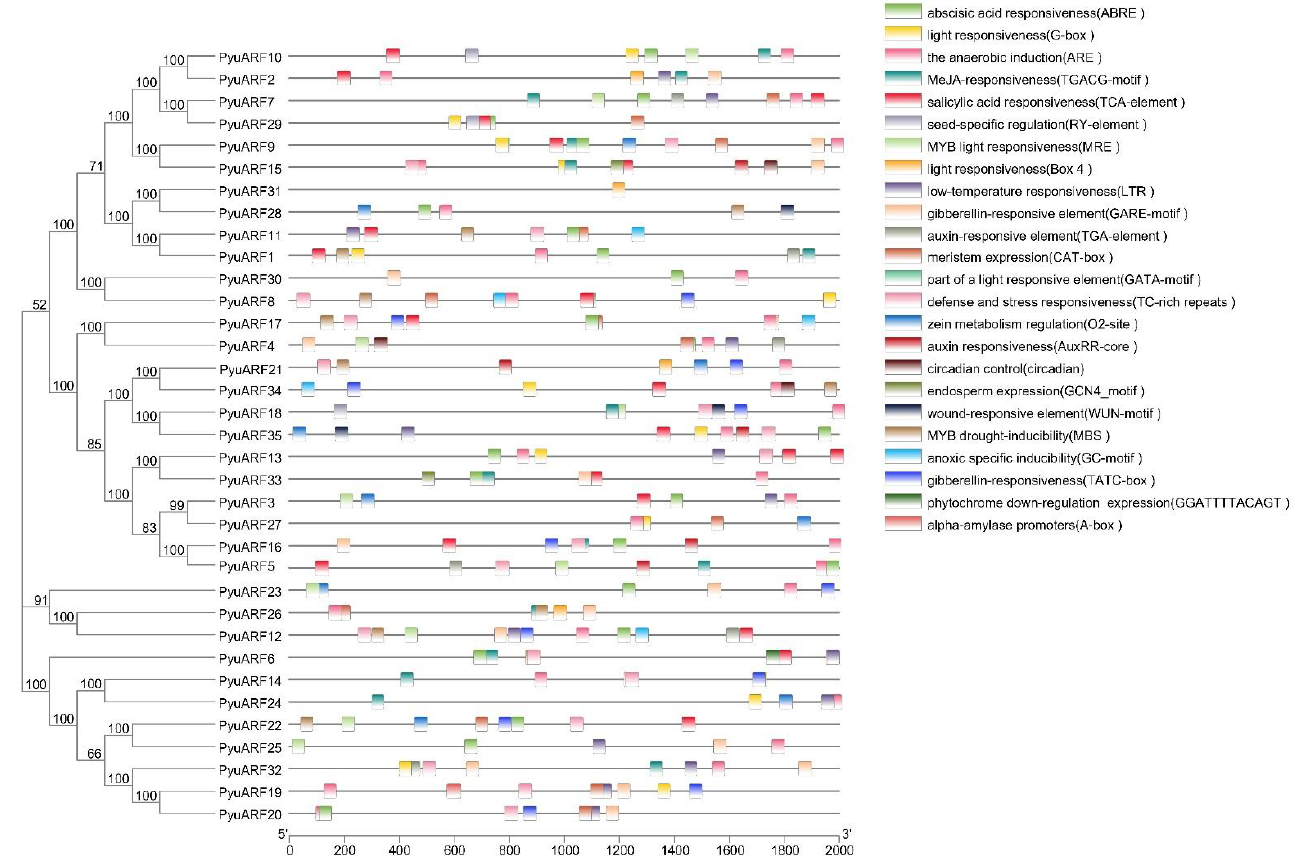
Figure 7. Cis-acting elements in the promoter regions of 35 PyuARFs . The black line indicates the promoter length of the PyuARFs . The different colored boxes on the right represent cis-acting elements with different functions.